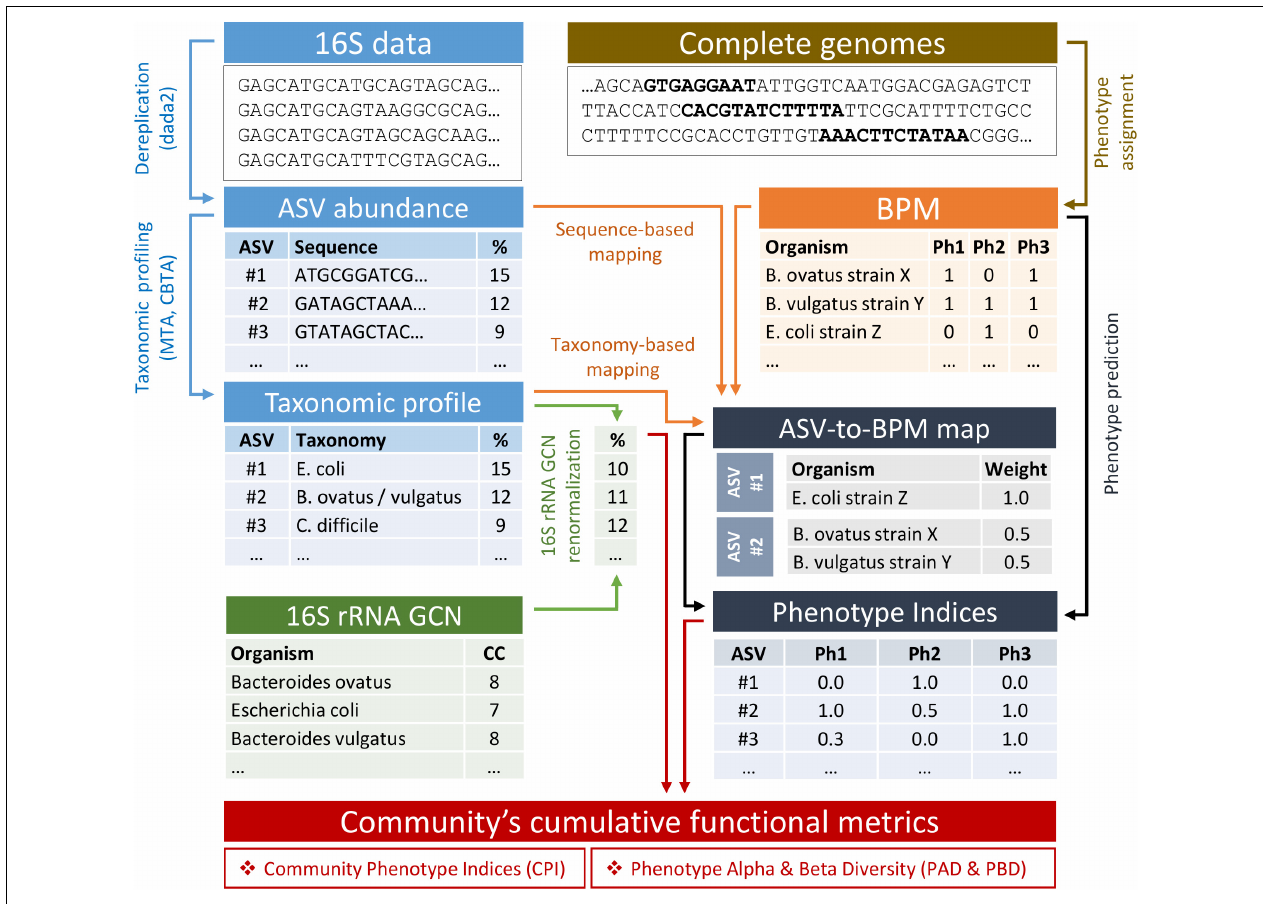
FIGURE 1 | Flowchart of the phenotype profiler